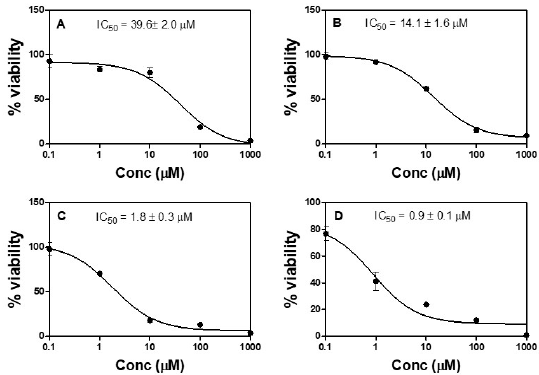
Figure 3. IC 50 of FLV ( A ), TAT ( B ), optimized FLV–TAT ( C ), and Mitomycin ( D ) in HepG2 cells. All incubation continued for 48 h; data represent the mean of six independent replicates ± SD.